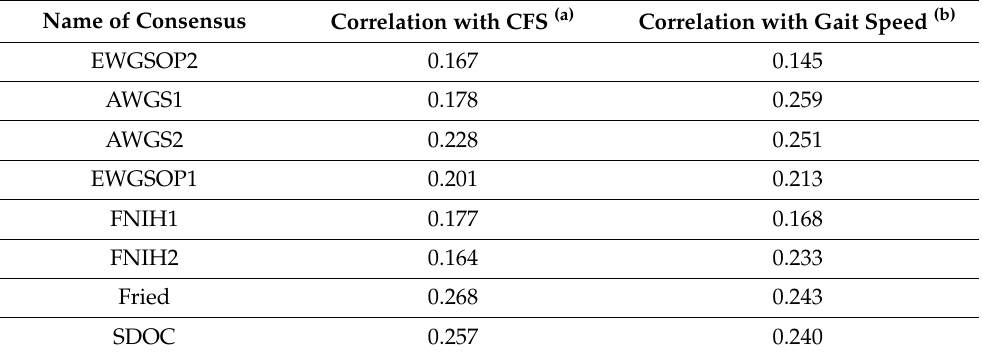
Table 5. Correlation coefficients (r) of cut-off definitions of low grip strength with clinical frailty scale (CFS) and gait speed ( n = 98). Name of Consensus Correlation with CFS (a) Correlation with Gait Speed (b) EWGSOP2 0.167 0.145 AWGS1 0.178 0.259 AWGS2 0.228 0.251 EWGSOP1 0.201 0.213 FNIH1 0.177 0.168 0.164